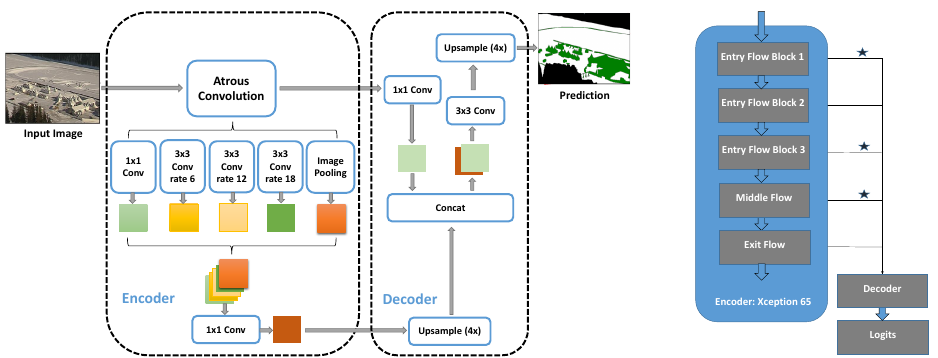
Figure 12. Deeplab v3+ ( left ) and Deep-U-Lab ( right ) architectures. The “ (cid:63) ” symbol indicates the additional skip connections for Deep-U-Lab